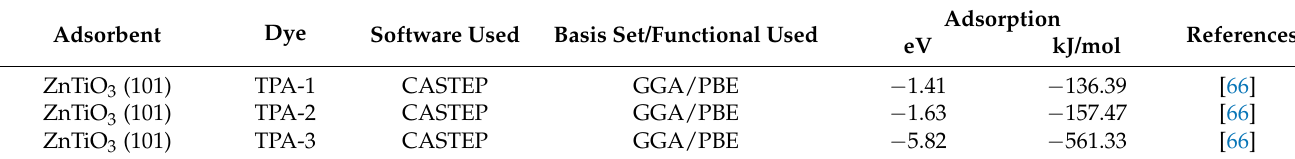
Table 2. Calculated adsorption energy of ZnTiO 3 and TiO 2 and other values reported in the literature. Adsorbent Dye Software Used Basis Set/Functional Used